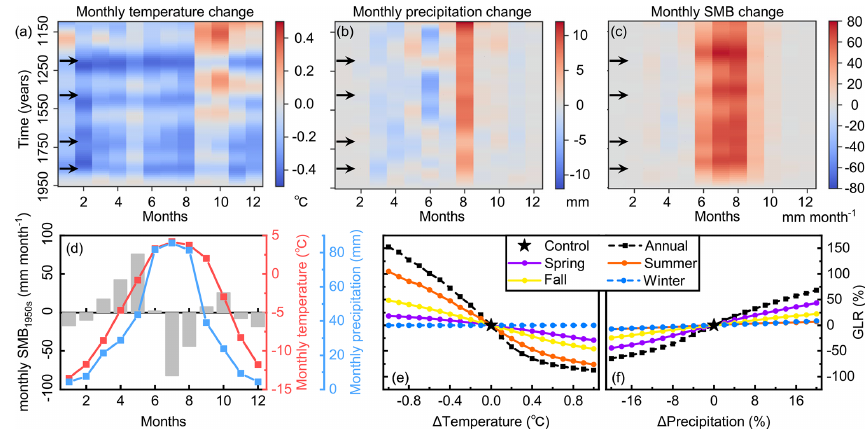
Figure 8. The monthly (a) temperature, (b) precipitation, and (c) SMB changes relative to the 1950s at a decadal timescale in the MC experiment. The arrows in (a) – (c) represent the times of the four glacial substages, the 1270s (LIA-4), the 1470s (LIA-3), the 1710s (LIA-2), and the 1850s (LIA-1). (d) The monthly temperature, precipitation, and SMB distribution in the 1950s. Sensitivity of GLR to annual or seasonal (e) temperature and (d)